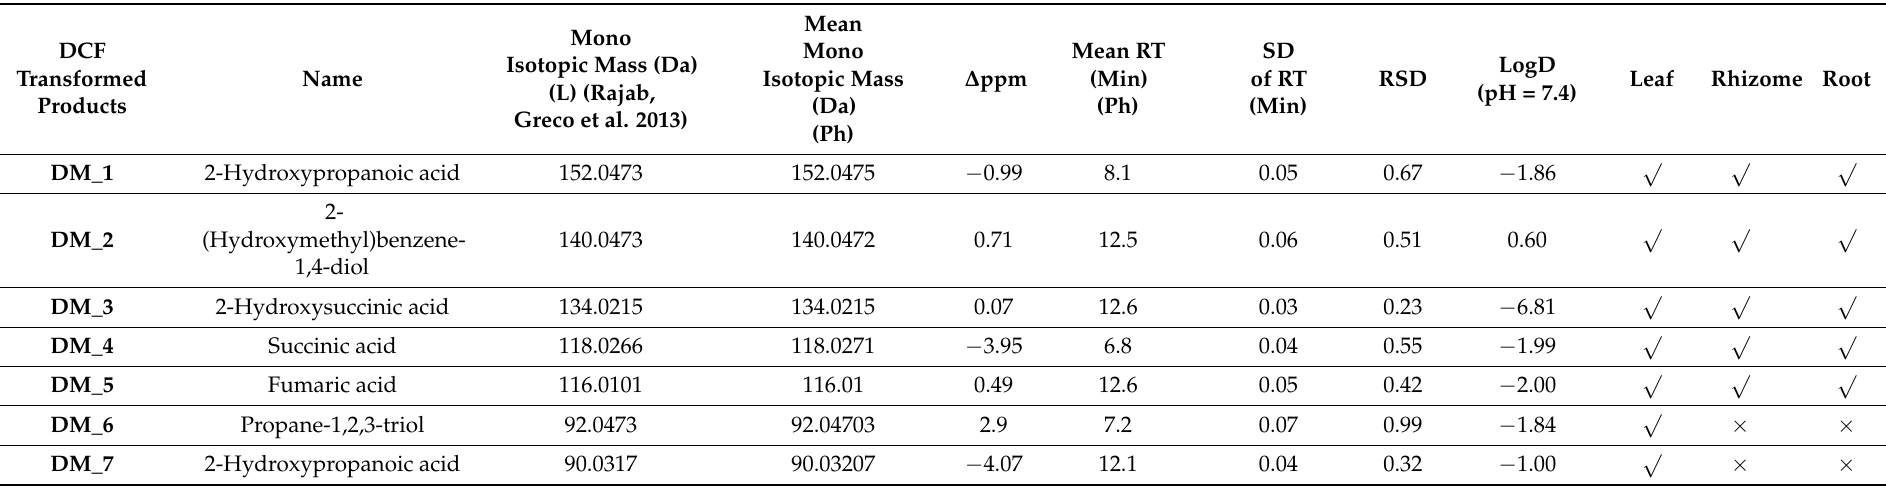
Table 1. List of diclofenac (DCF) transformation products detected in different Phragmites australis leaf, rhizome and roots incubated with 10 and 100 µ M diclofenac samples with the relative standard deviation and LogD (pH = 7.4) were listed. The logD values were predicted from ChemAxon software